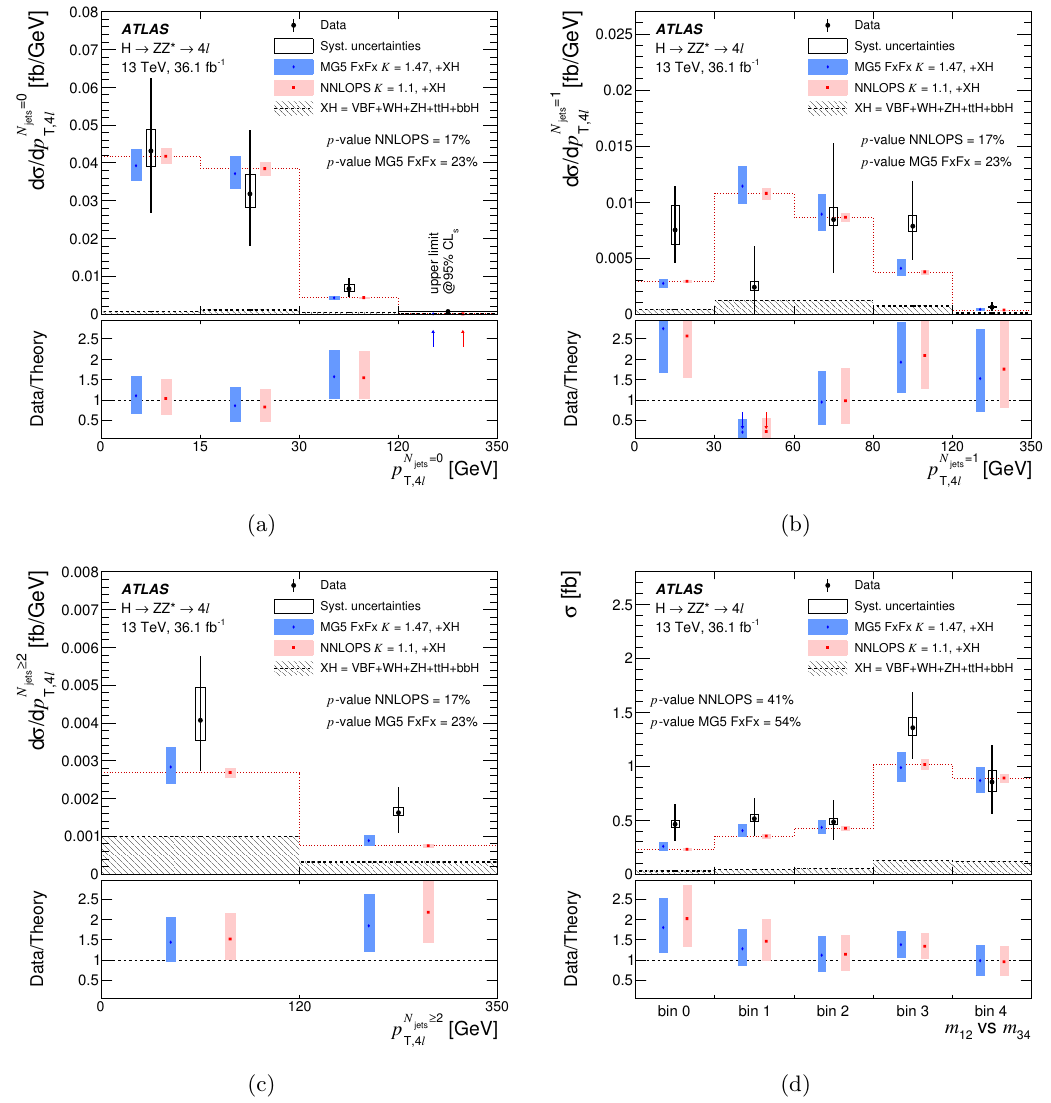
Figure 10. Figures (a){(c) show di(cid:11)erential (cid:12)ducial cross sections of the transverse momentum p T ; 4 ‘ of the Higgs boson for di(cid:11)erent jet multiplicities N jets , and (d) shows the invariant mass of the leading lepton pair vs that of the subleading pair, m 12 vs m 34 . The binning of m 12 vs m 34 is the same as presented in (cid:12)gure 3(d). The measured cross sections are compared to ggF predictions by NNLOPS and MG5 aMC@NLO FxFx , all normalized to the N3LO cross section with the listed K -factors. Predictions for all other Higgs boson production modes XH are added. The error bars on the data points show the total uncertainties, while the systematic uncertainties are indicated by the boxes. The shaded bands on the expected cross sections indicate the PDF and scale uncertainties. For the cross sections as a function of p T ; 4 ‘ , the p -values re(cid:13)ect the level of agreement for the three jet bins together, treating them as a two-dimensional distribution.